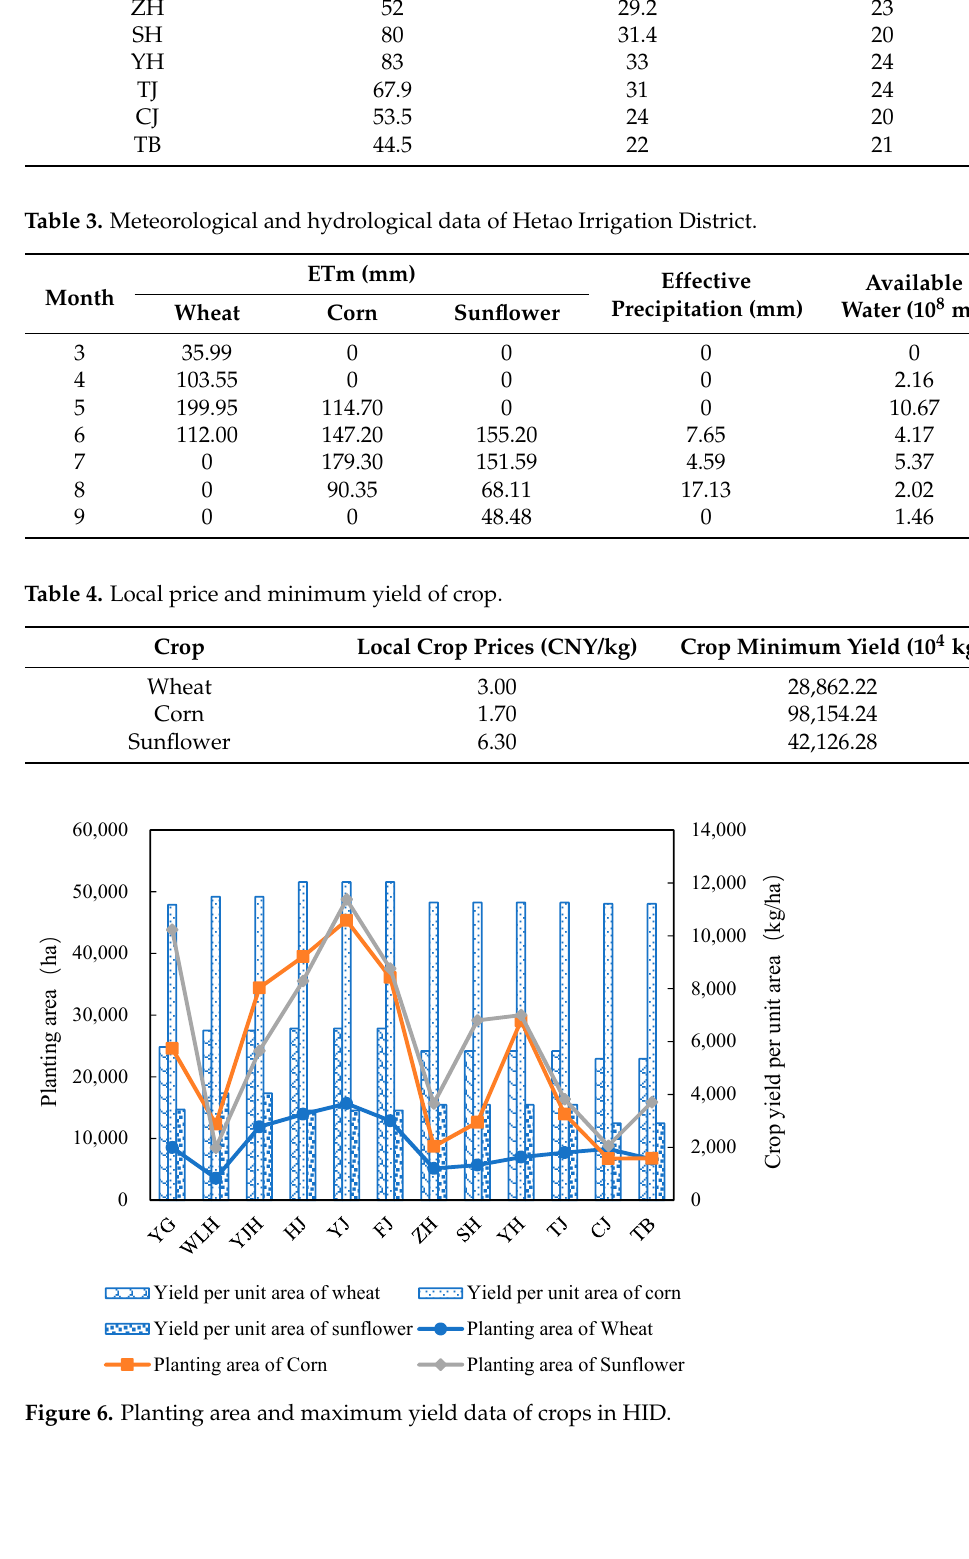
Figure 7. Spatial data of agricultural output value and grain yield in HID: ( a ) Agricultural output value; ( b ) grain yield.